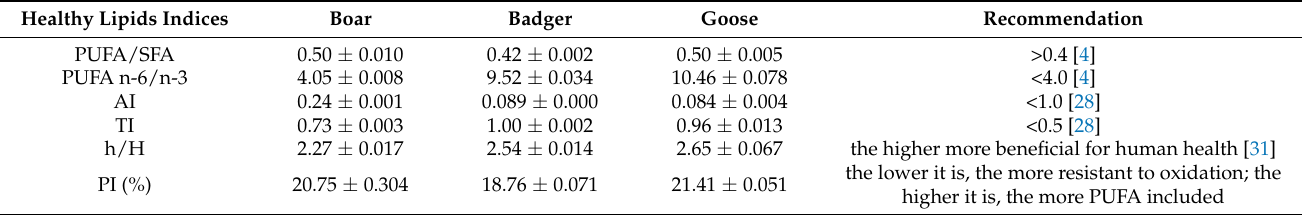
Table 4. Nutritional and healthy quality of the adipose tissue-derived from wild animal (mean values ± standard deviation). Healthy Lipids Indices Boar Badger Goose Recommendation PUFA/SFA 0.50 ±